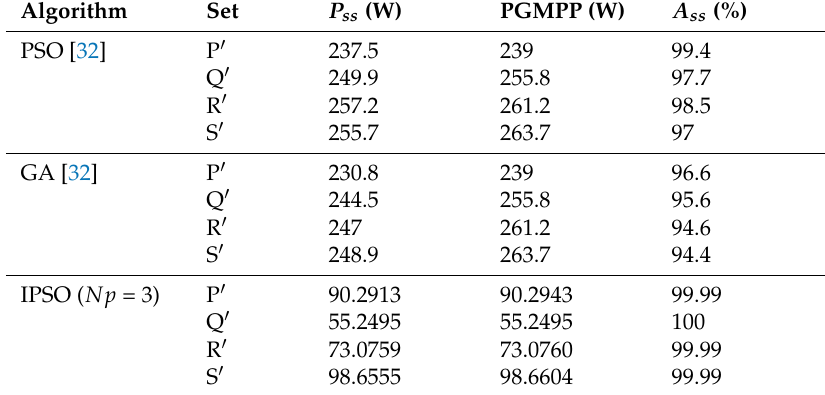
Table 11. Accuracy comparison between techniques (Improved Particle Swarm Optimization (IPSO)) and (Particle Swarm Optimization (PSO), Genetic Algorithm(GA)) methods under partial